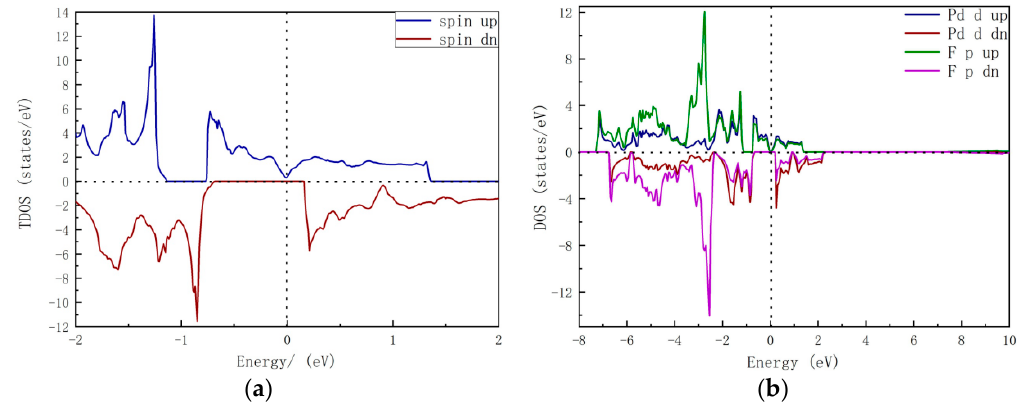
Figure 2. ( a ) Total and ( b ) projected density of states of rhombohedral-type PdF 3 bulk. The Fermi level was set to zero. TDOS = total density of states.